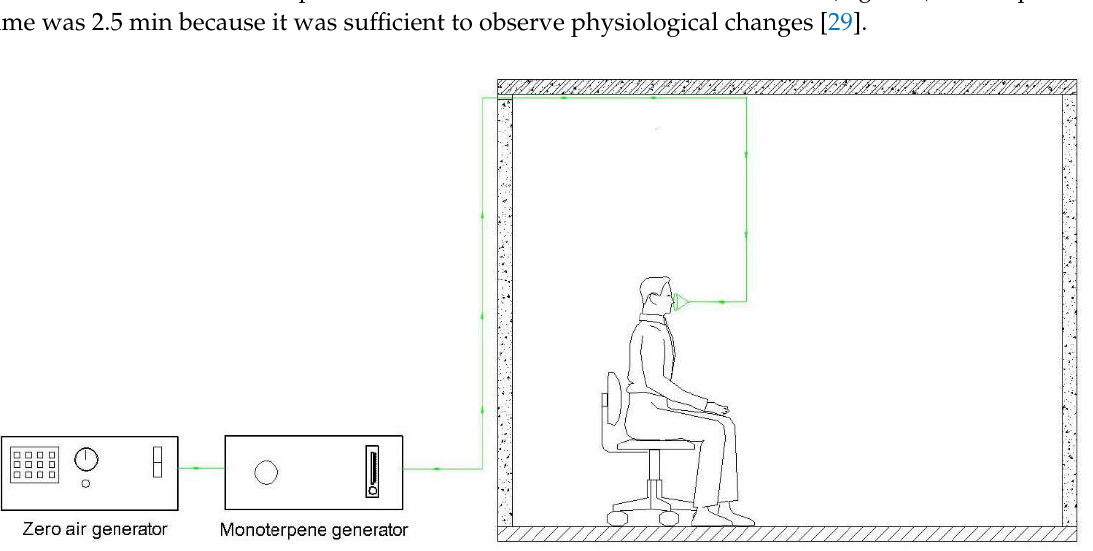
Table 2. Questionnaire for the assessment of human responses to the odors of α - pinene, β - pinene, d - limonene.